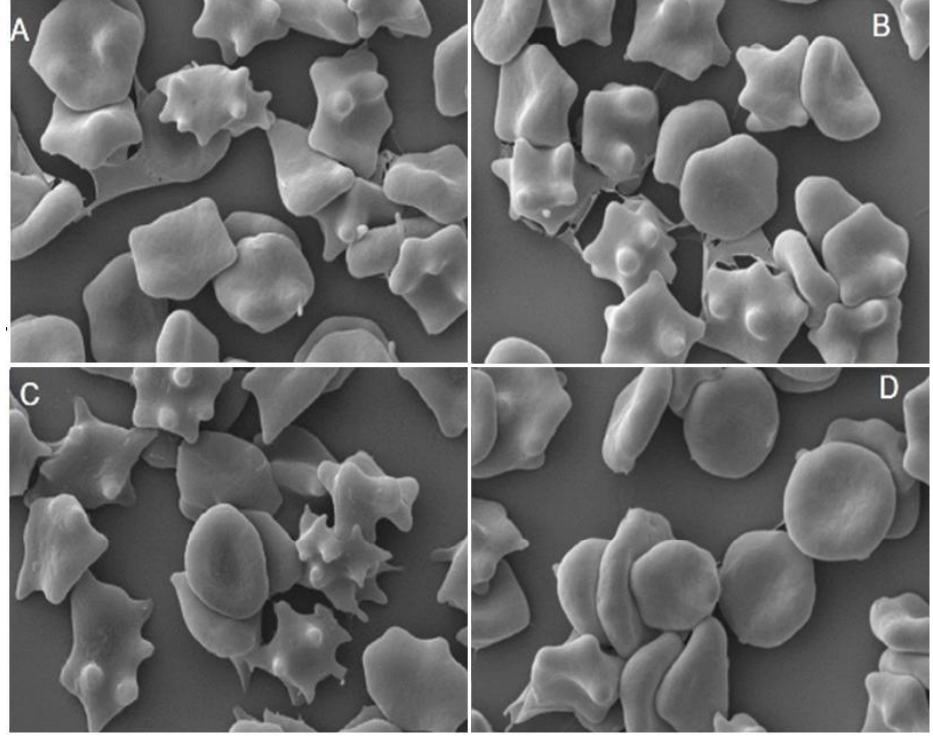
Figure 4. Example shapes of erythrocytes modified by Rubus leaf extract at 10 ( A ) and 50 µg/mL ( B ), Fragaria leaf extract at 50 µg/mL ( C ) and unmodified ( D ).